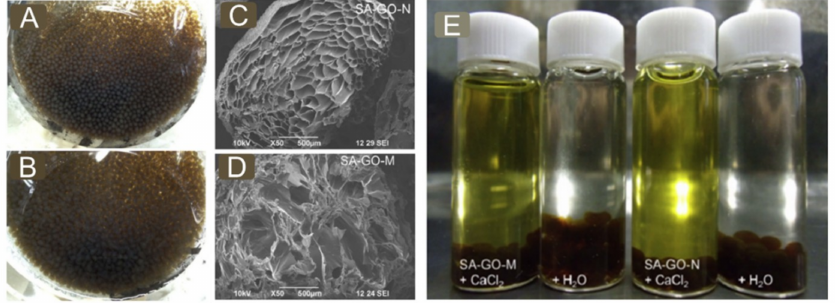
Figure 10. ( A ) Ca 2+ cross-linked GO-alginate composite beads(SA-GO-N); ( B ) Acid-gelled GO-alginate composite beads (SA-GO-M);( C ) a SEM image of freezing-dry bead SA-GO-N; ( D ) a SEM image of the bead SA-GO-M; ( E ) naked-eye comparison of color changes upon dye-adsorbing beads (SA-GO-M and SA-GO-N) were immersed in the CaCl 2 ~0.5 mol/L solution and deionized water. Adapted with permission from [119]. Copyright Elsevier,